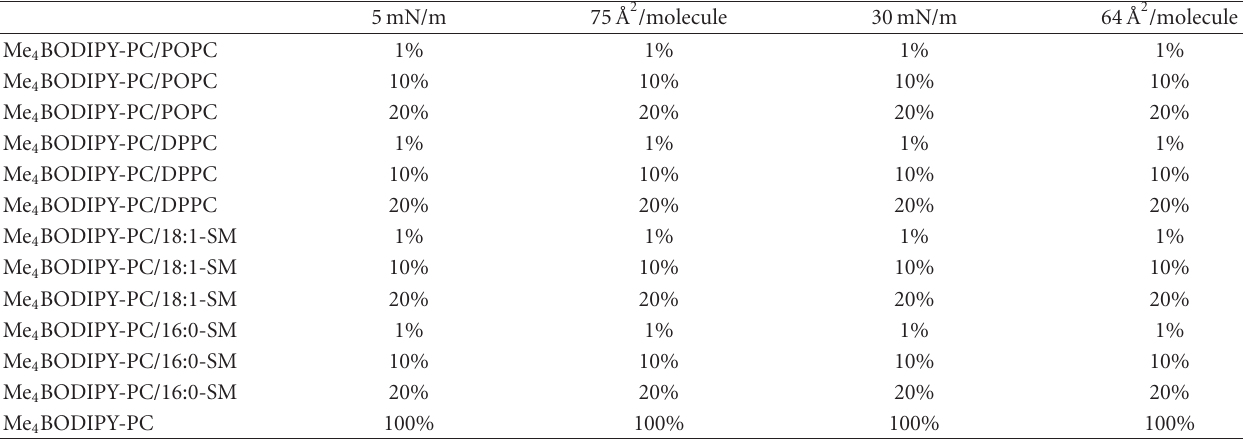
% indicates Me 4 BODIPY-PC mole%. The first and third columns represent surface pressure. The second and fourth columns represent cross-sectional molecular area.